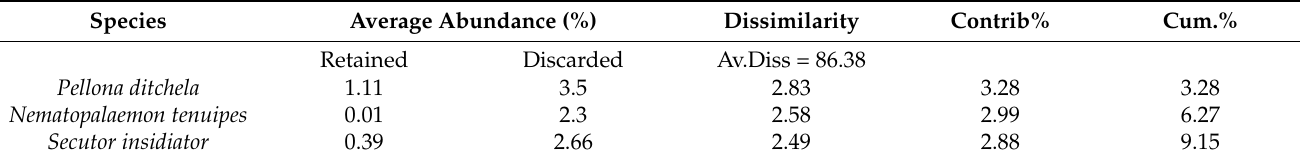
Figure 6. Non-metric multidimensional scaling ordination plots of retained vs. discarded species. Table 3. Summary of SIMPER analysis showing the average dissimilarity in the species composition between retained and discarded catch and three species that contributed most to the overall dissimilarities.